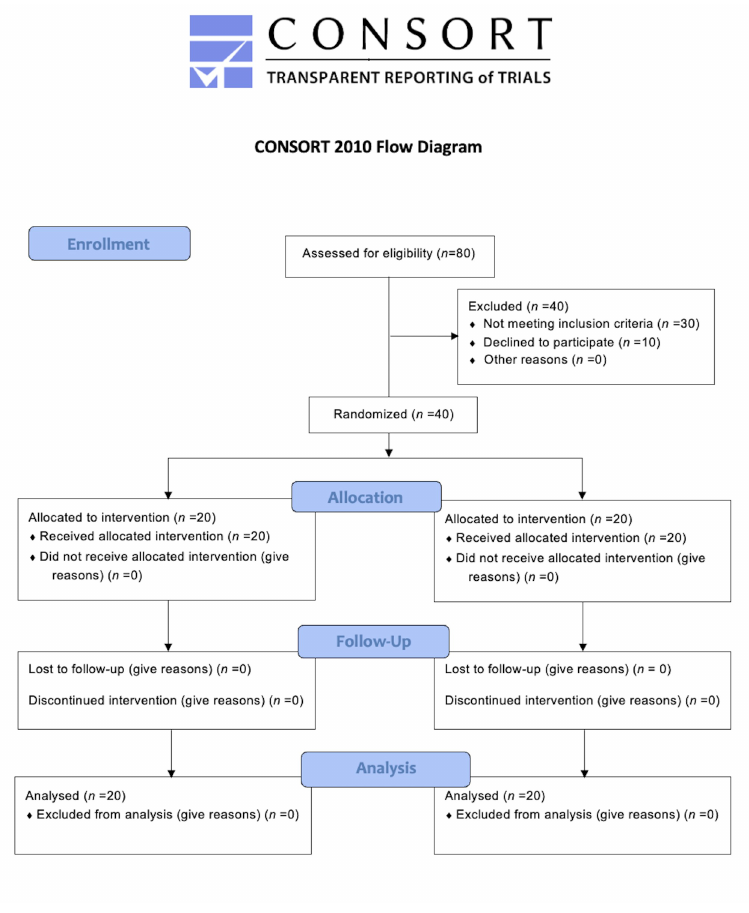
Figure 1. Flow chart of the study. Table 1. Numerical characteristics of Study Group and Control